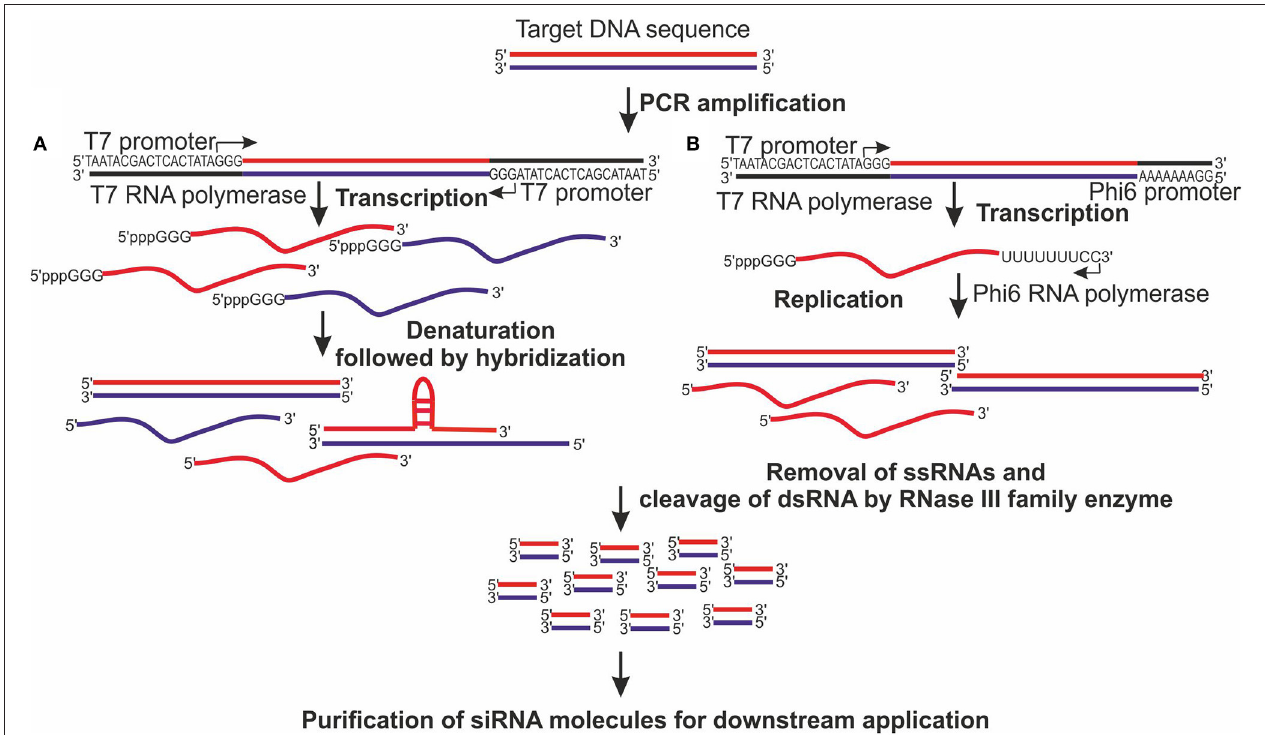
FIGURE 1 | Enzymatic production of siRNA pools. (A) Target-specific DNA template is generated by PCR with forward and reverse primers containing at their 5 ′ ends promoter sequence for T7 DNA-dependent RNA polymerase. T7 polymerase transcribes purified DNA into single-stranded RNA (ssRNA) molecules, which are subsequently heated at 75 ◦ C for 5min to denature secondary and tertiary ssRNA structures and to allow proper strand annealing. Nevertheless, long ssRNA molecules are prone to formation of branched structures and hairpins, which are difficult to denature and which prevent proper hybridization, and decrease the amount of full-length double-stranded RNAs (dsRNAs). (B) DNA template is generated by PCR with forward primer containing a promoter sequence for T7 polymerase and reverse primer comprising a promoter sequence for Phi6 RNA-dependent RNA polymerase. The resulting product is purified and a single-tube reaction is set up, where T7 polymerase transcribes DNA into ssRNA and Phi6 polymerase replicates the second strand of the RNA molecule. This approach results in a higher yield of full-length, biologically active dsRNA molecules compared to that where annealing step is used to generate dsRNA. (A,B) The generated dsRNAs